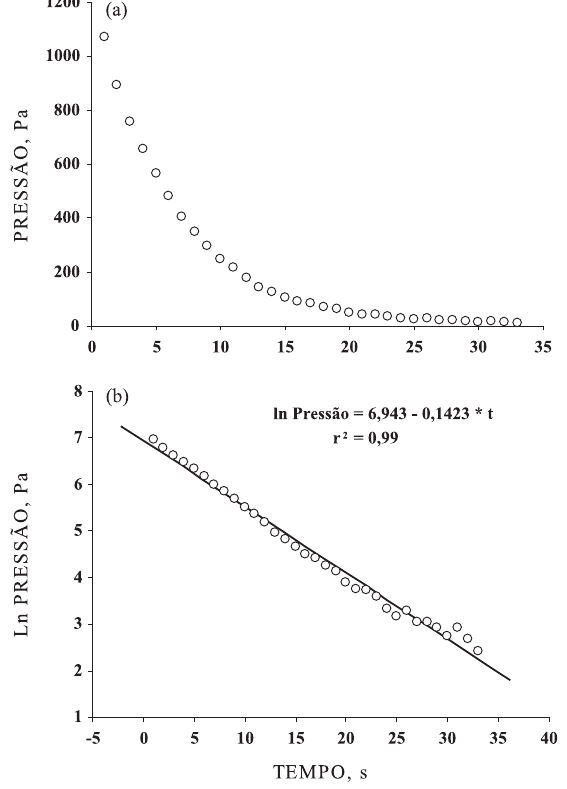
Figura 2. Relação entre decréscimo da pressão versus tempo para uma amostra indeformada de solo do estudo E1. Relação observada experimentalmente (a) e relação linearizada (b), de em que é obtida inclinação S (em módulo) utilizada no cálculo da permeabilidade ao